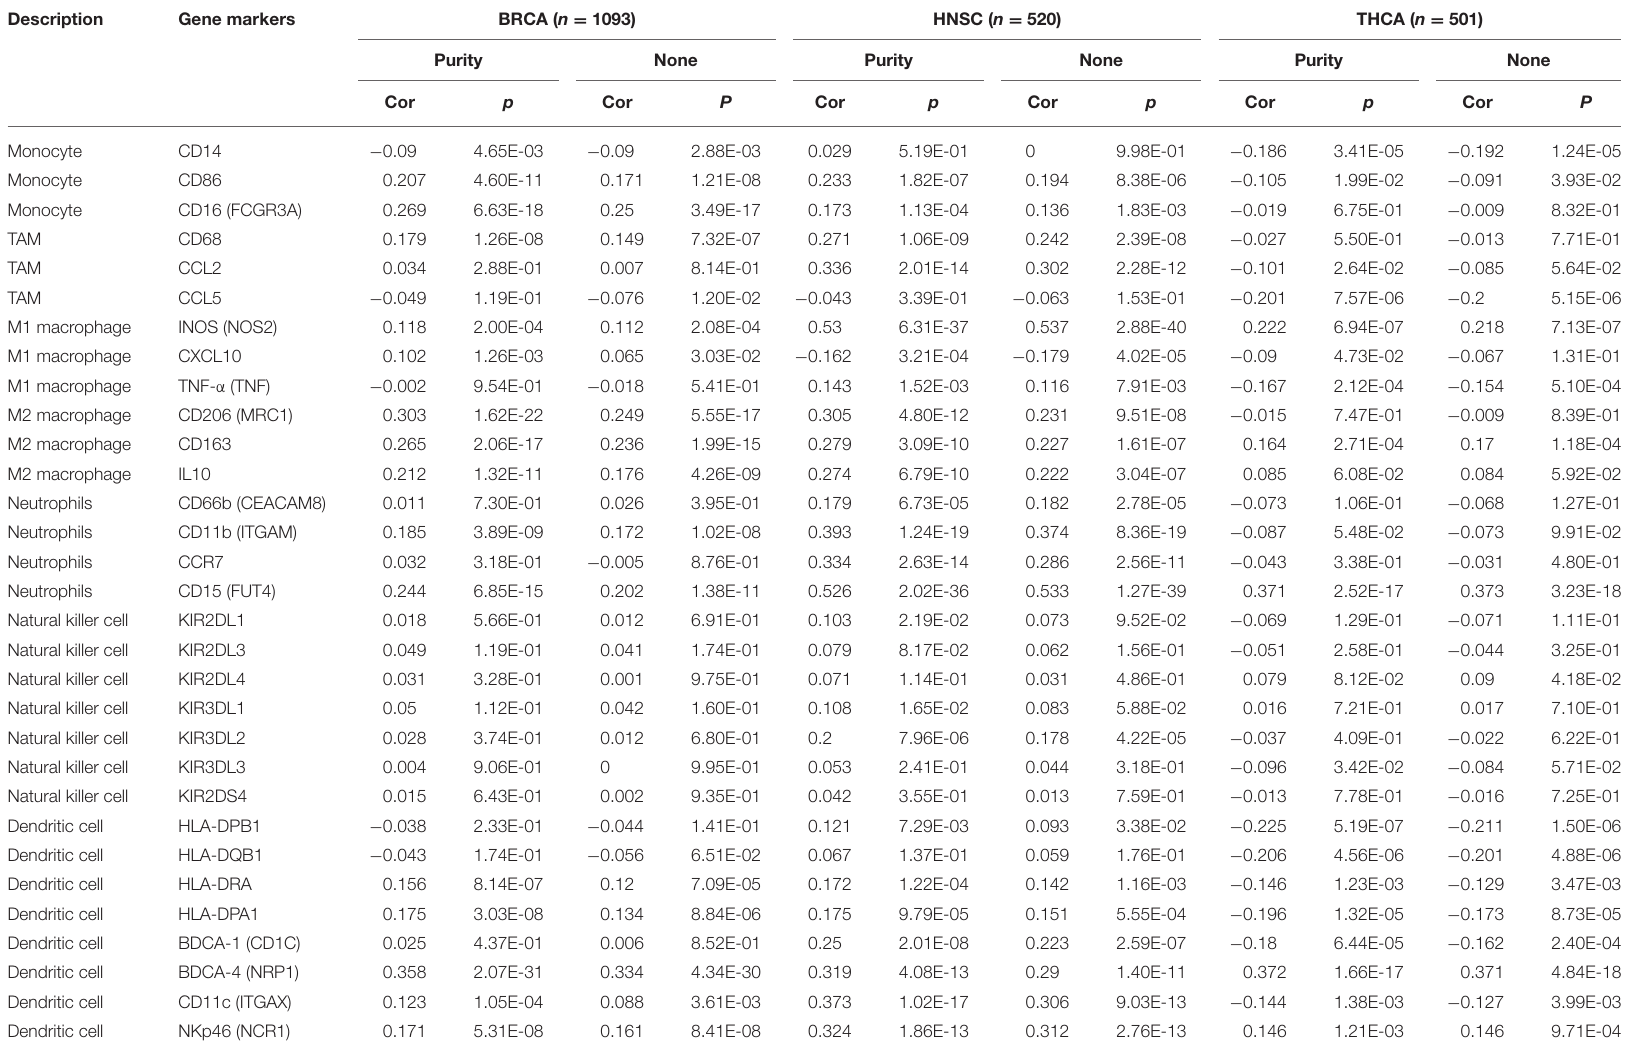
TABLE 2 | Correlation analysis between PERK and related gene markers of innate immune cells in TIMER in BRCA, HNSC, and THCA.